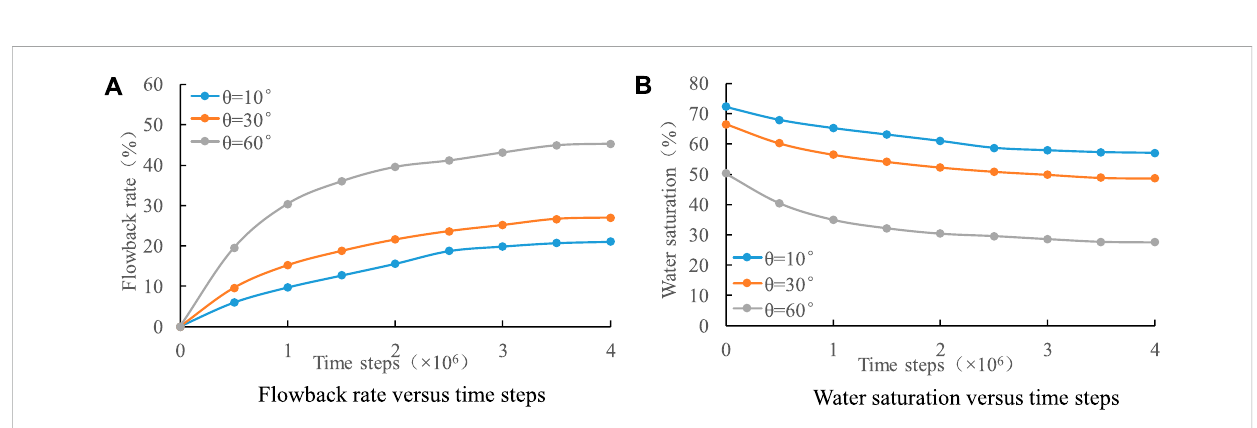
FIGURE 14 The fl owback rate versus time steps (A) and the water saturation versus time steps (B) in the fl owback process under different contact angles.